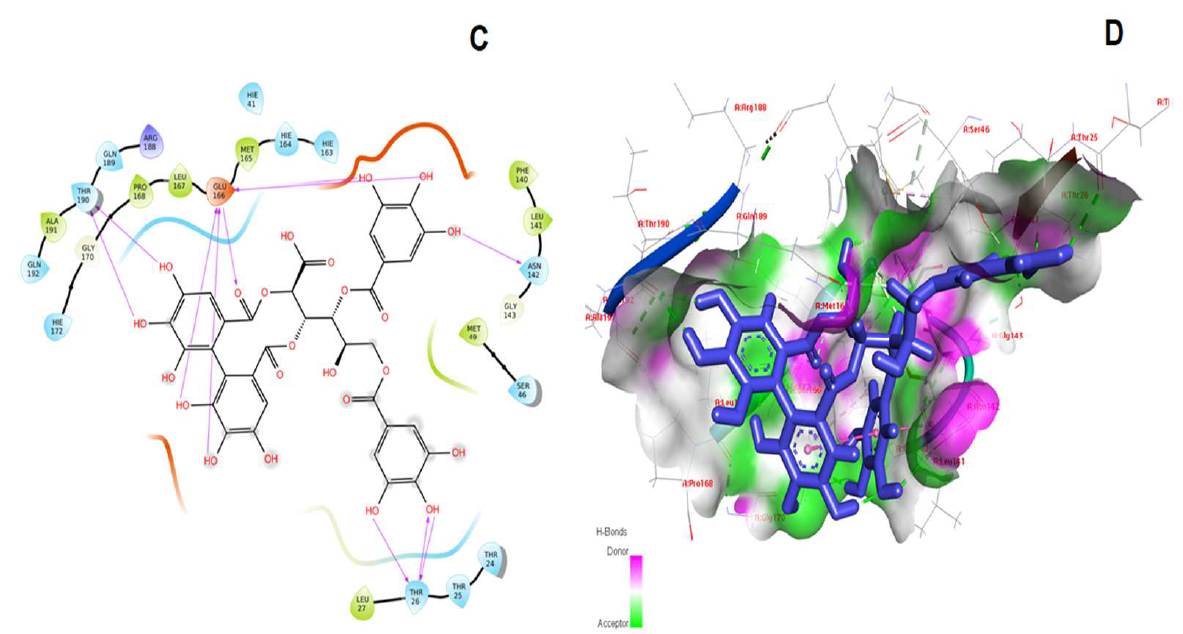
Figure 3. ( C , D ) Illustrations of the interaction between Shephagenin B and the target M pro protein of SARS-CoV-2.